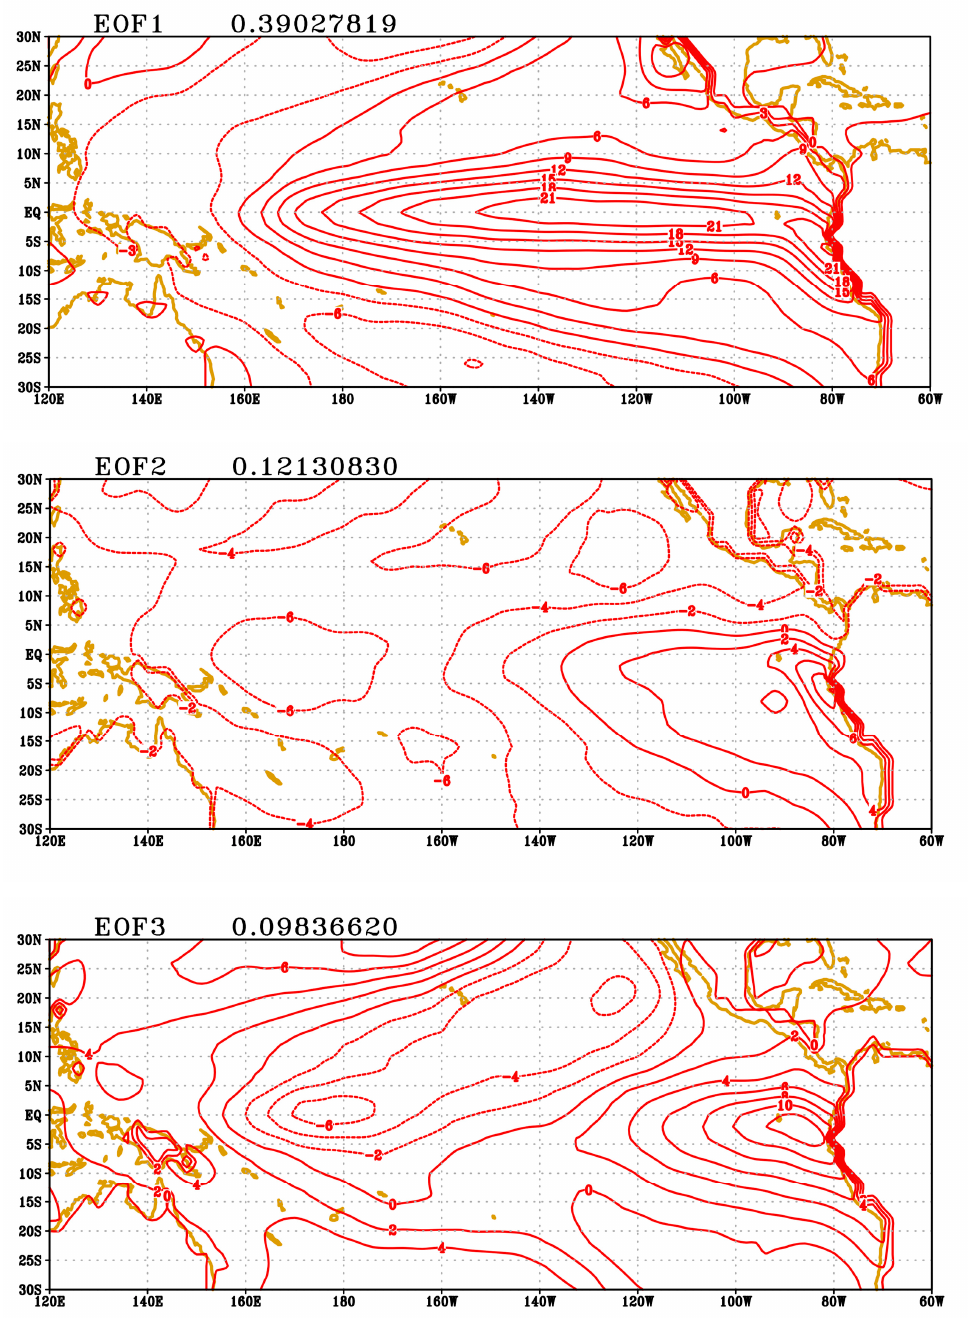
Figure 5. The first three spatial eigen modes (EOFs) of the PCA. The number in the top legend of every figure is the ratio of the explained